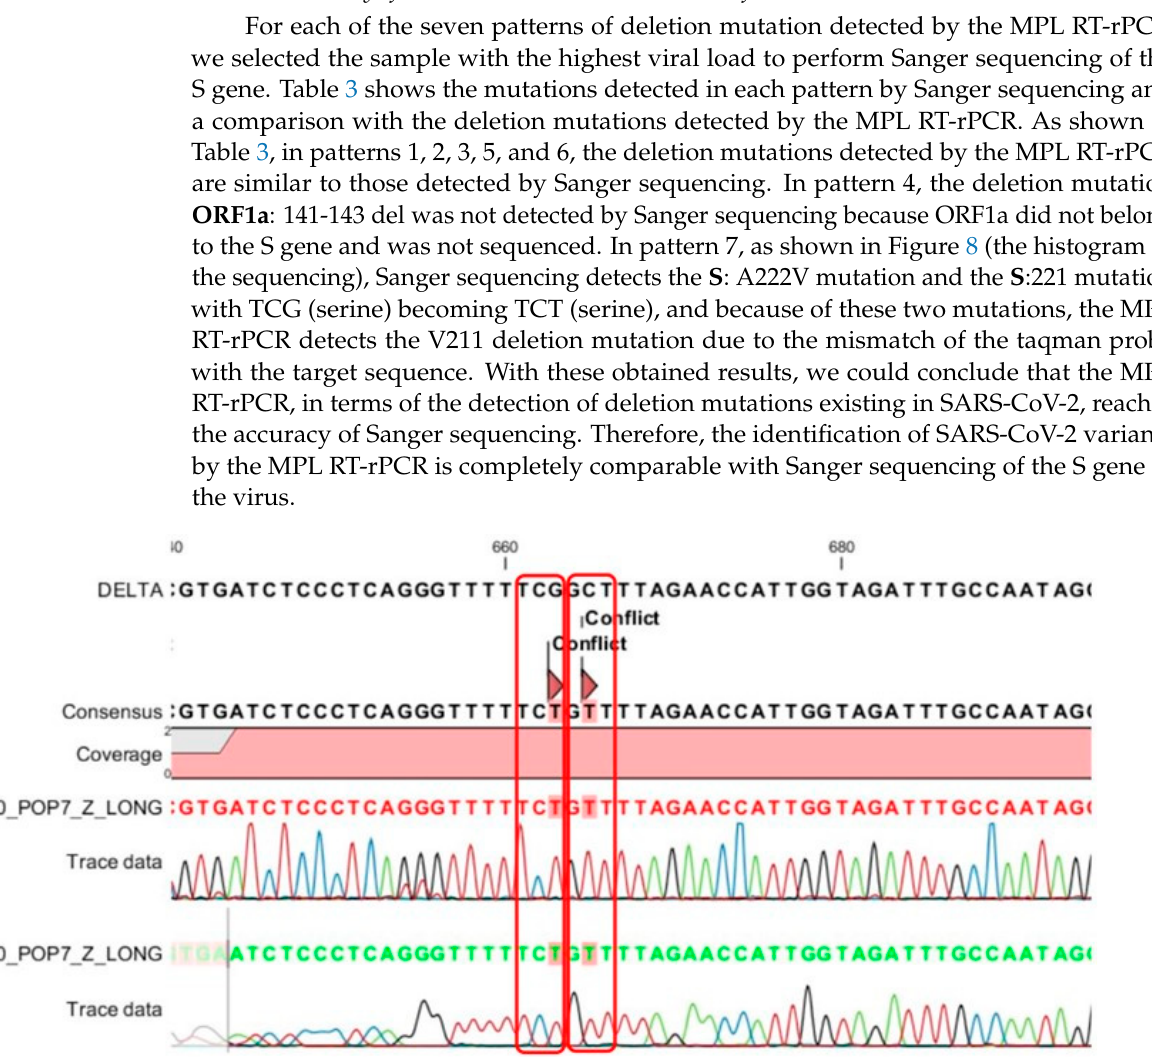
Figure 7. In MPL1 : The target failure is detected in TexasRED channel. In MPL2 , the target failure is detected in channel FAM. No amplification is detected in channel CY5 because of the competition of high viral load with the IC (human RNAse P). This pattern is identified as variant Delta . The distribution of the variants detected among the 3239 SARS-CoV-2 [+] samples was